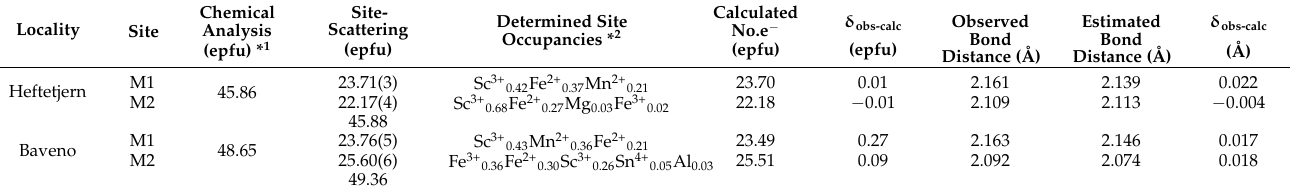
Table 5. Cation distribution and estimated bond distances at the M1 and M2 sites.